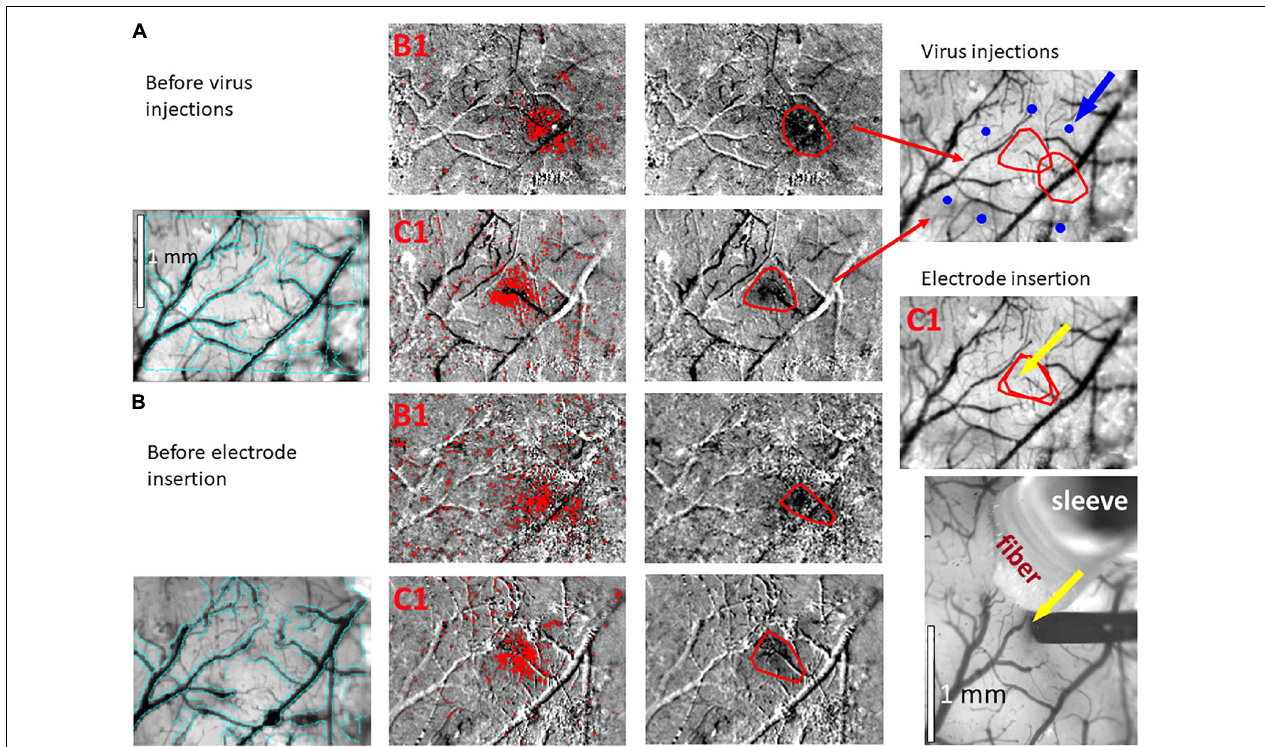
FIGURE 3 | Hemodynamic responses to single-whisker piezoelectric stimulations. (A) OI-IS through the thinned skull for guiding microinjections. The left-most panel shows an image of a mouse’s right hemisphere. This image was taken under green light illumination (peak wavelength of 530 nm) at the beginning of the experiment to obtain the pial vessel topography. The cyan curves are edges of the pial vessels computed before the insertion of the electrode (left-most panel in B ) and superimposed on the pial vessels image before the injections, for demonstrating the alignment of the imaged regions and responses. The scale bar represents 1 mm. Each row presents OI-IS steps in their chronological order, for stimulating a single whisker: B1 or C1, respectively. The second column presents images of hemodynamic responses to single whisker stimulation, averaged over ten trials. Pixels with superimposed red dots showed statistically significant responses. The third column shows the perimeter (red curves) encompassing the responding region, obtained by computing the convex hull around all clusters of connected responding pixels. The image in the fourth column overlays the perimeters computed in response to stimulating the B1 and C1 whiskers on top of the green reference image to localize the hemodynamic response with respect to the pial vessels topography. It outlines the overall stimulus-activated region comprising the responses to all the stimulated barrels (red curves), so that microinjections (blue circles; indicated by a blue arrow) can be planned around it, as close as possible to the barrels of interest without damaging these barrels and/or pial blood vessels. (B) OI-IS following a craniotomy, for guiding the insertion of the recording electrode and the positioning of the optic fiber. The first three columns are identical in scope to those presented in (A) . The cyan colored curves present the edges of the pial vessels computed (using Canny edge detection) from the green image obtained before electrode insertion. The upper image in the right-most column shows in red curves the delineation of the responses stimulating whisker C1 before the injections and before the insertion of the electrode. The yellow arrow points to the position of electrode insertion. The lower image is a high-magnification image of the region where the electrode was inserted. The experimenter selects a site for recording (yellow arrow) in the center of a barrel whose location is estimated by the hemodynamic response, along with the region where photostimulation will be applied. In the bottom-right panel, the electrode is shown after it was inserted at the recording site (yellow arrow). The tip of the optic fiber is placed on top of the cortical surface immediately adjacent to the electrode; the fiber’s protective outer sleeve is seen out of focus. The scale bar represents 1